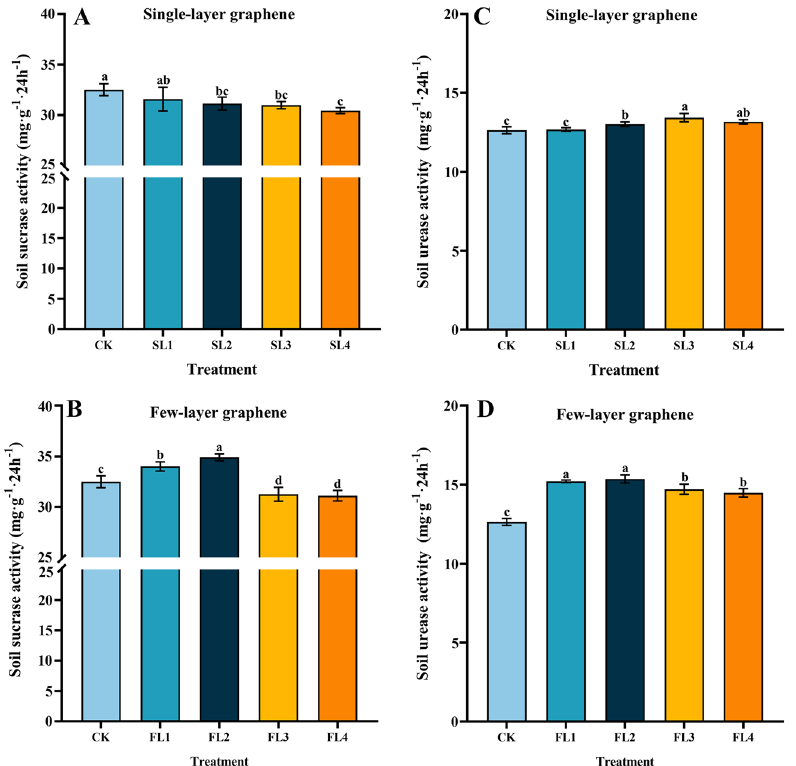
Figure 3. Effect of different graphene concentration and type on soil sucrase activity, urease activity. CK. 0 g kg −1 single-layer graphene and 0 g kg −1 few-layer graphene; SL1 and FL1. 25 g kg −1 single-layer graphene and 25 g kg −1 few-layer graphene; SL2 and FL2. 50 g kg −1 single-layer graphene and 50 g kg −1 few-layer graphene; SL3 and FL3. 100 g kg −1 single-layer graphene and 100 g kg −1 few-layer graphene; SL4 and FL4. 150 g kg −1 single- layer graphene and 150 g kg −1 few-layer graphene; ( A , C ) single-layer treatment; ( B , D ) few-layer treatment; error bars indicate ± standard deviation. Different letters above error bars indicate significant difference between treatment ( p < 0.05, LSD